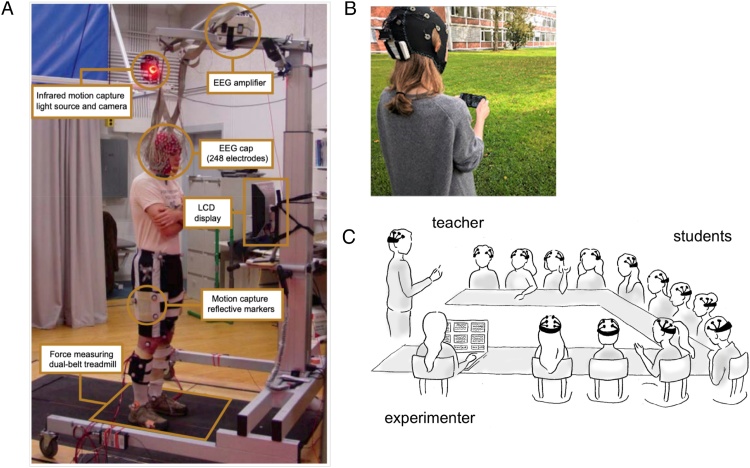
Illustration of innovative EEG-based paradigms facilitated by ongoing mobile EEG developments. Examples include a set-up a) for mobile brain/body imaging (MoBI) allowing for body movements merging EEG with other motion-based sensors, adapted from Gramann et al. (2010); b) using mobile EEG while walking with smartphone-based stimuli presentation (of word stimuli) in an outdoor setting (i.e., a pre-specified route), adapted from Piñeyro Salvidegoitia et al. (2019); c) using mobile EEG simultaneously in multiple individuals within an indoor social setting (i.e., in the classroom), adapted from Dikker et al. (2017).